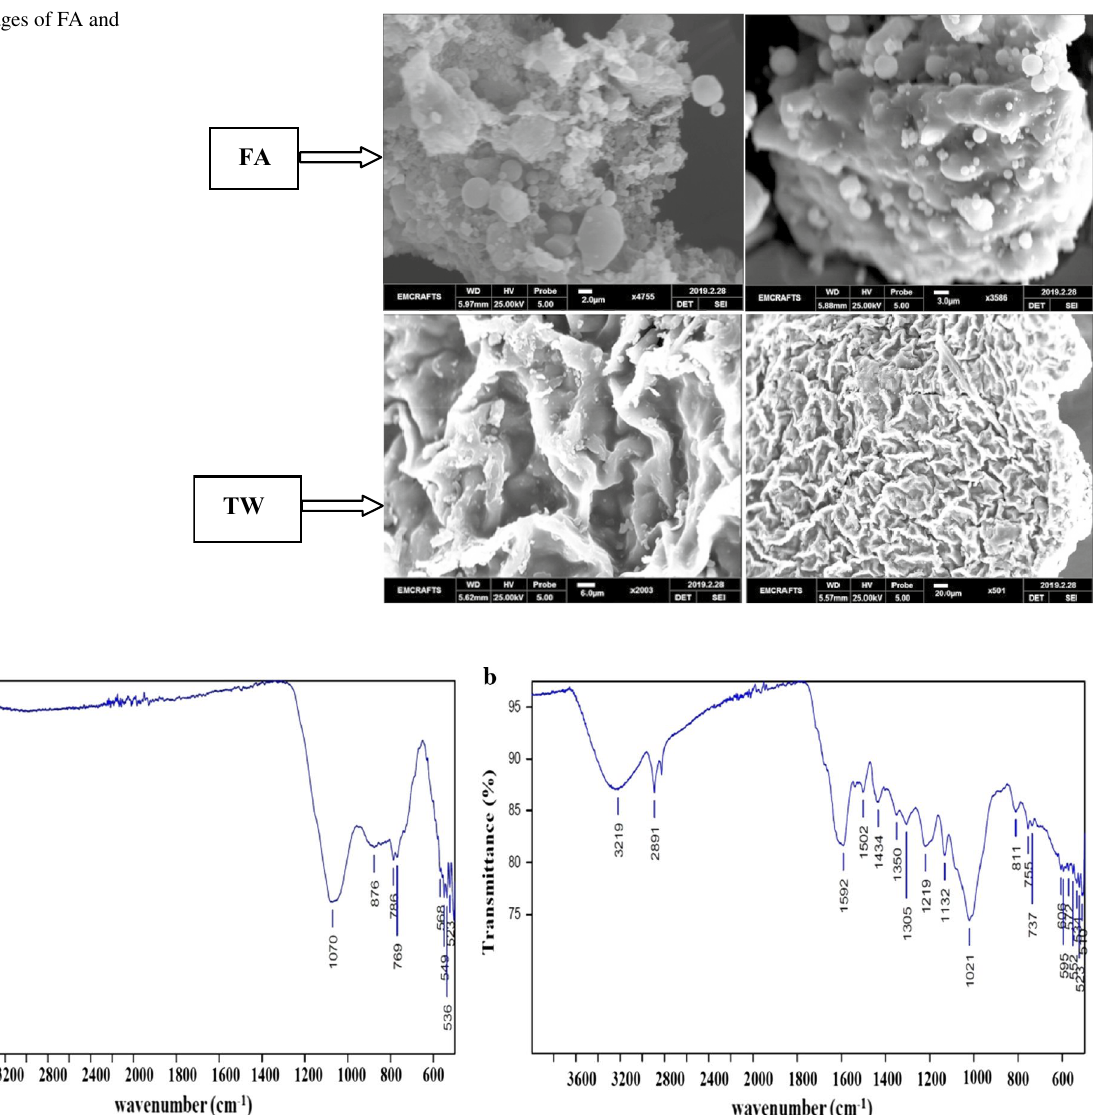
Fig. 9 FTIR spectrum of a FA and b